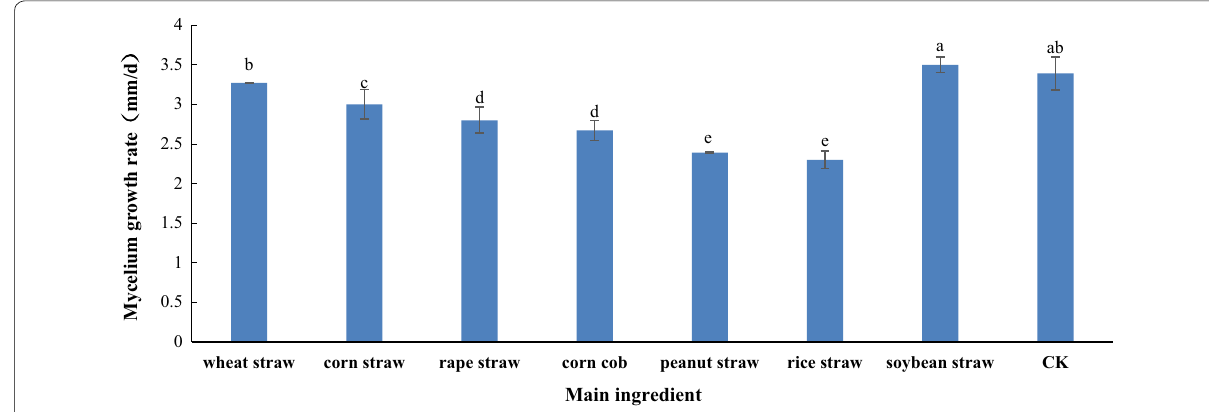
Fig. 1 Effect of different agro-residue substrates on mycelial growth rate in Petri dishes. Mean values followed by no letters are not significantly different at a level of 5% (P <